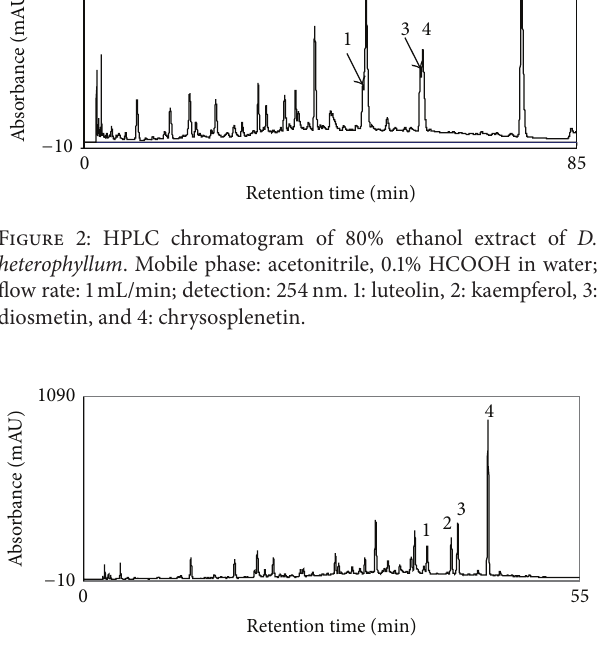
Figure 3: HPLC chromatogram of 80% ethanol extract of